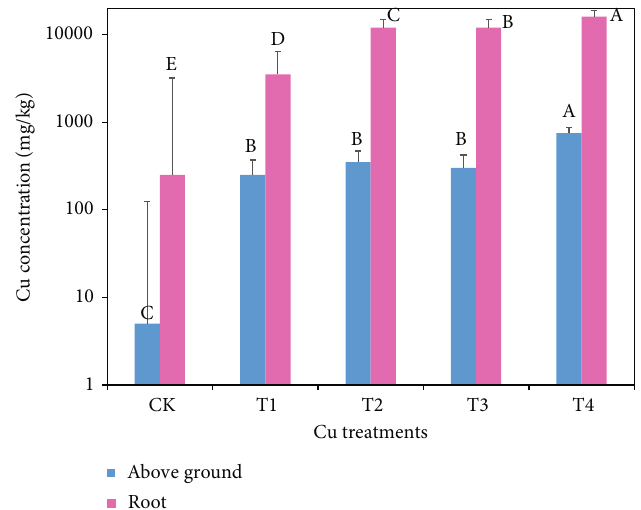
Figure 2: Cu content in di ff erent parts of willow.